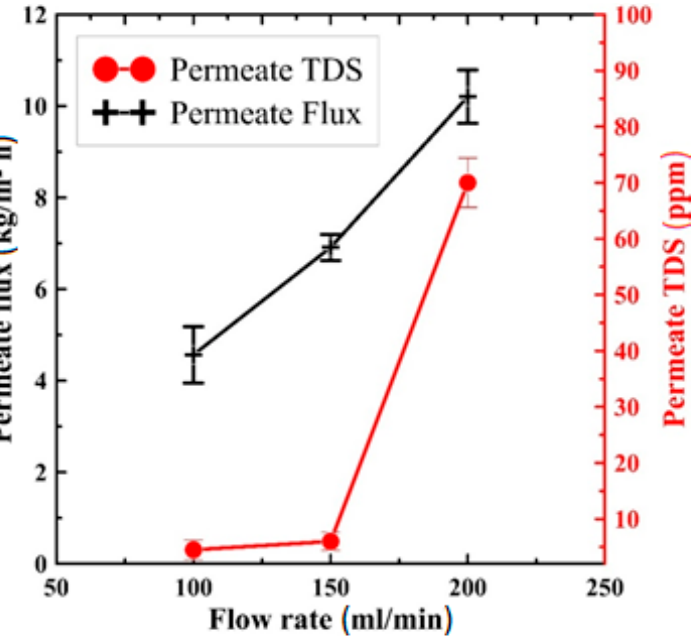
Figure 9. Effect of feed flow rate on permeate flux and TDS of the produced water at 85 °C saltwater inlet temperature and 10,000 ppm feed salt concentration.